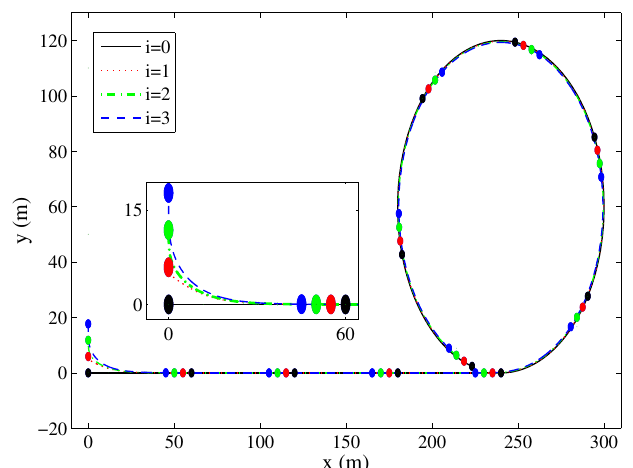
Figure 6. The north-east position of the four USVs under the model-based control.